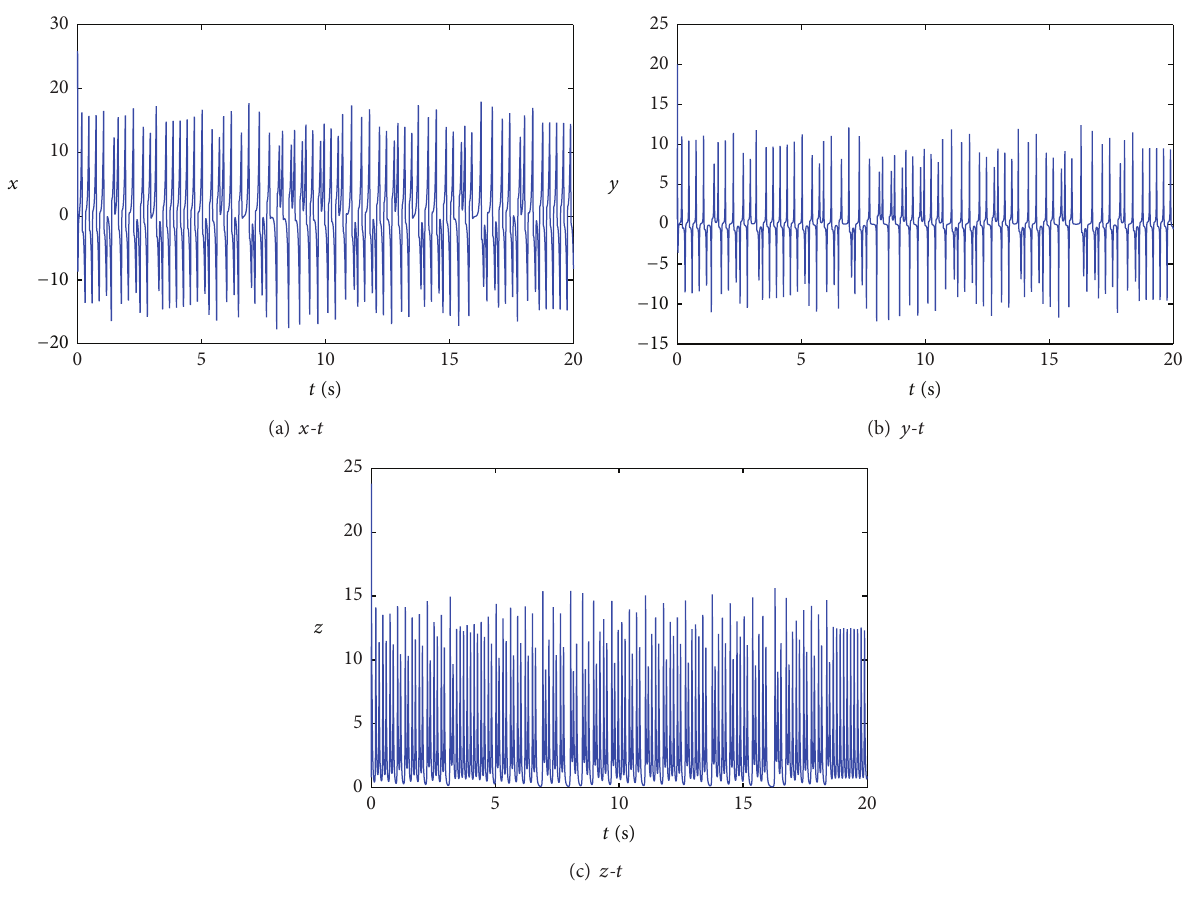
Figure 8: State trajectories of system (5) without